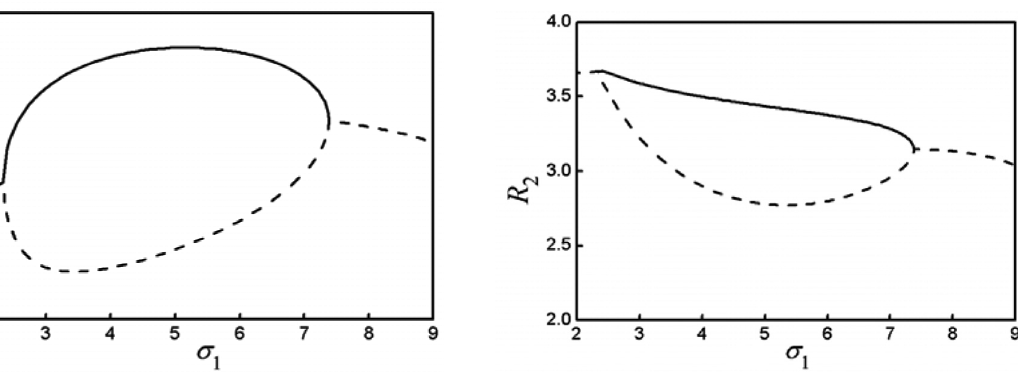
Fig. 1. Variation of R 1 with σ 1 . Fig. 2. Variation of R 2 with σ 1 .